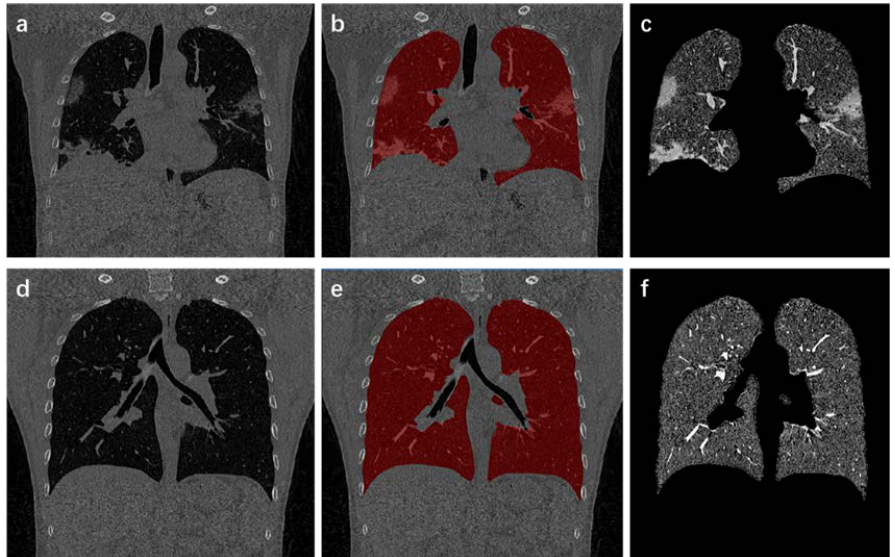
Figure 3. Process and results of lung region extraction. ( a , d ) are the original CT images; ( b , e ) show results of lung mask covering the original CT images; ( c , f ) indicate the extracted lung area.